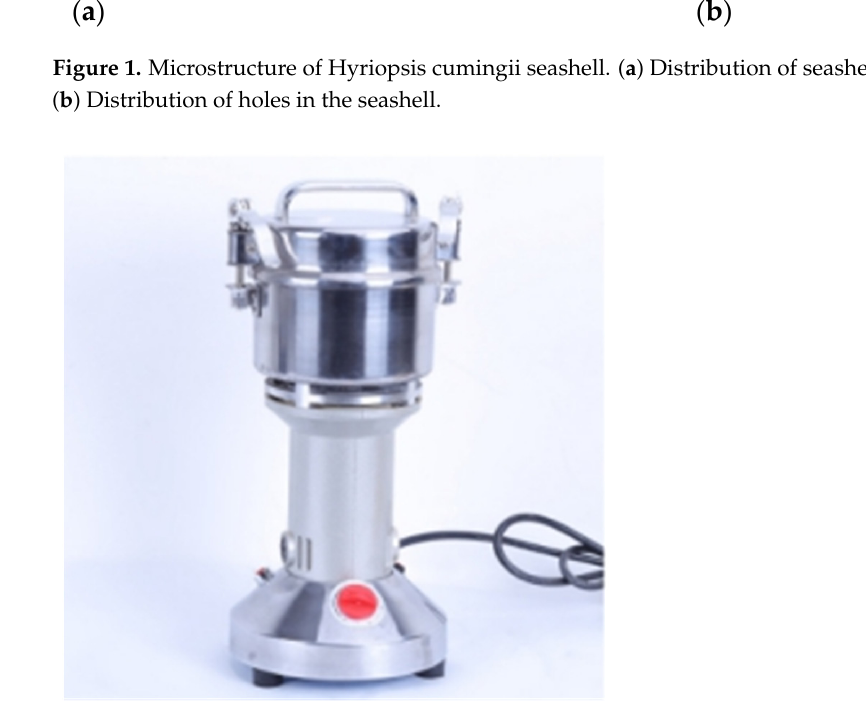
Figure 1. Microstructure of Hyriopsis cumingii seashell. ( a ) Distribution of seashell structure layer; ( b ) Distribution of holes in the seashell.